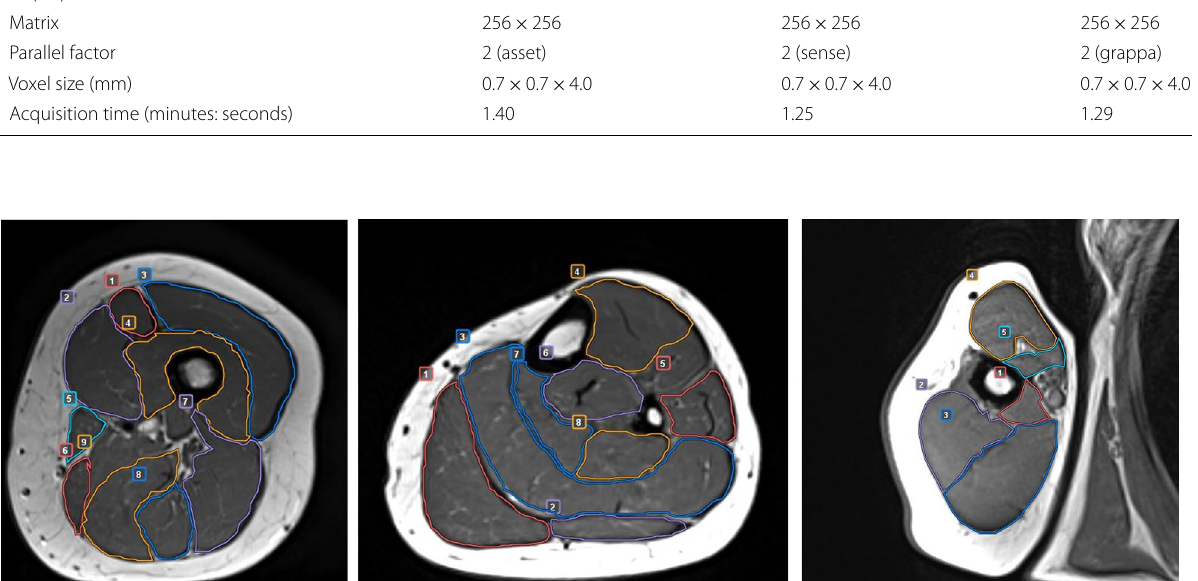
(Table 5). MD measurements for reader two were close to significance ( p 0.0573). =